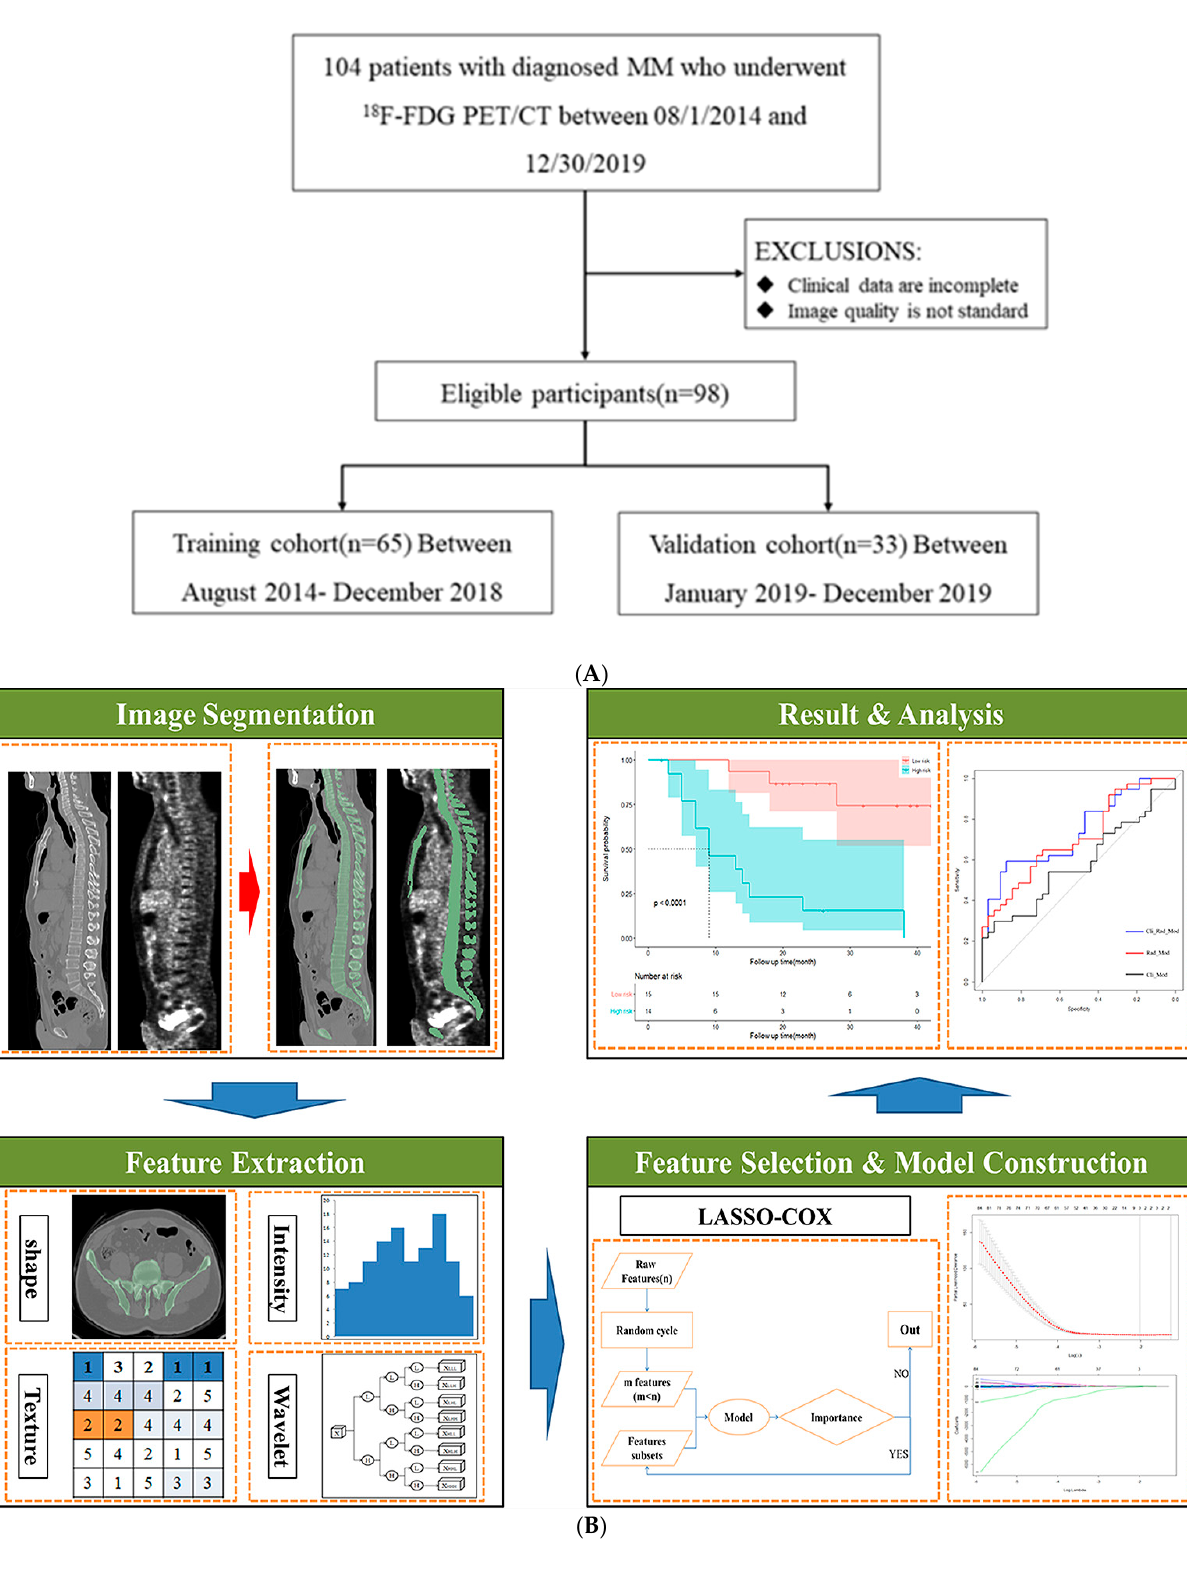
Figure 1. ( A ) Flowchart of the patient selection process. ( B ) Radiomics workflow. First, a region of interest is defined and/or lesions are segmented. A frequently large number of feature candidates are extracted. Optimal features are screened by Lasso algorithm and 10-fold cross-validation. Prognostic scores were generated for each multivariate Cox model by summing the product of each feature retained in the different